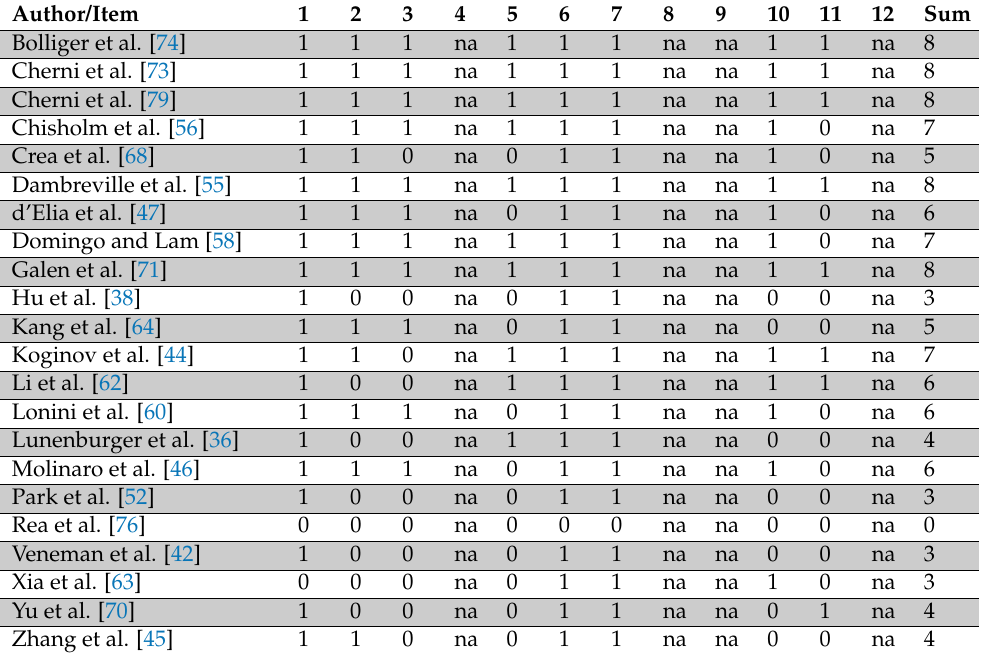
Table 3. Results of the quality assessment of validity and reliability studies. The reader is referred to National Heart, Lung and Blood Institute (2021) [35] for further details on the different items of the quality assessment tool (na, not